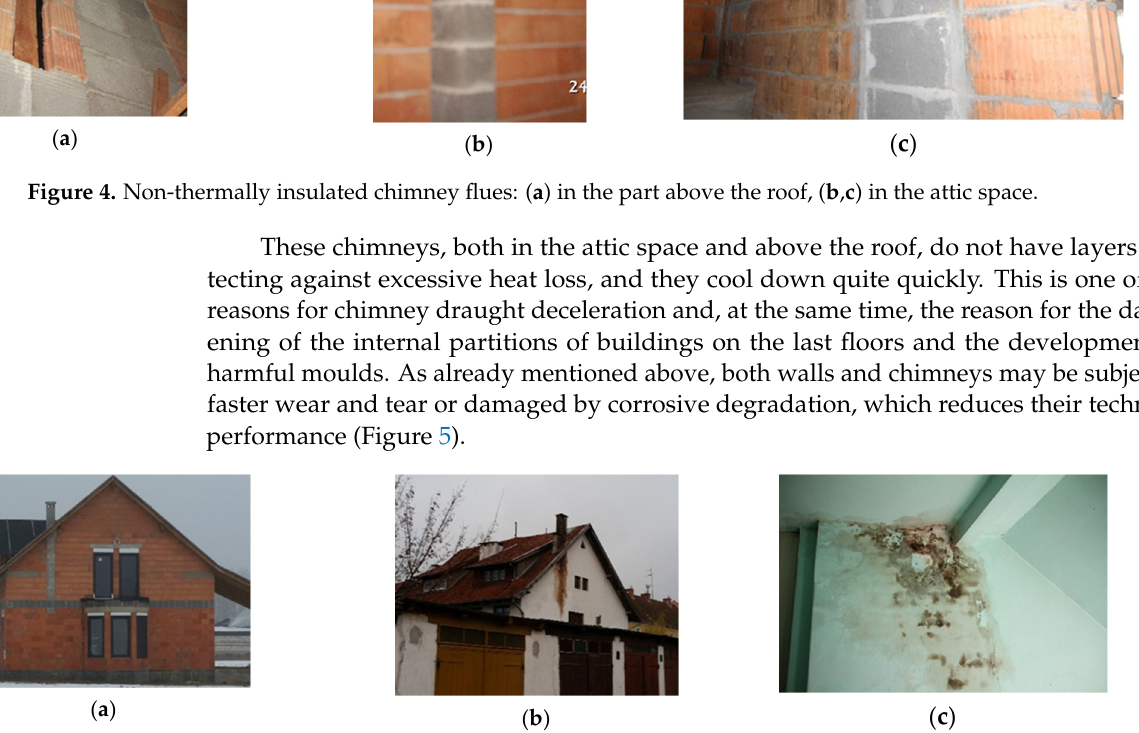
( b ) Figure 6. Thermal ( a ) image of the temperature distribution on the surface of the chimney wall in visible light ( b ). Temperature distribution on the surface of a chimney located in an attic space con- taining smoke and ventilation ducts (Figure 7). ( a ) ( b ) Figure 7. Thermal ( a ), and visible light ( b ) images of the chimney wall in the attic space (at the inspection grille). Figure 8 shows a certain stage in the modernisation of a single-family building through the introduction of prefabricated system chimneys. The effect of their inadequate